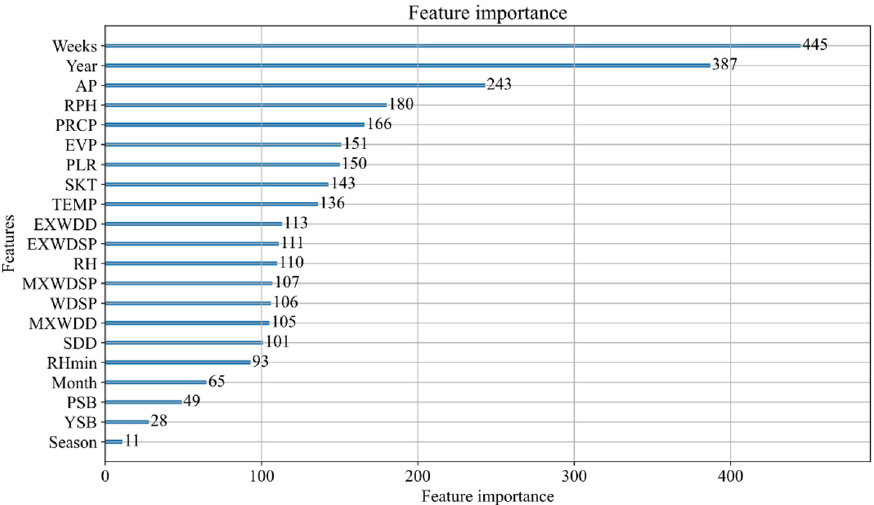
Figure 3. Variable importance derived from the GBDT model for natural log-transformed ln (SRSB) light trap catches in Yuanjiang.